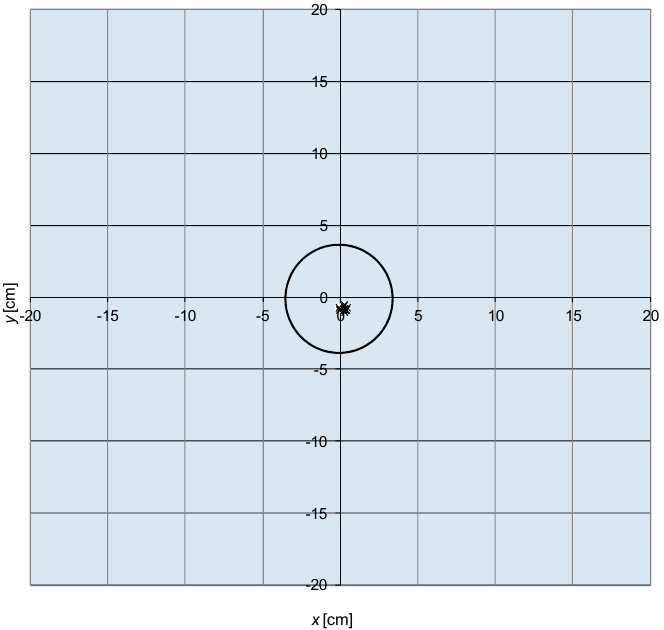
Figure 12. Location of the defect based on a series of ten measurements (the location of the defect is marked with x); the circle is the outline of the insulator placed centrally inside the system.